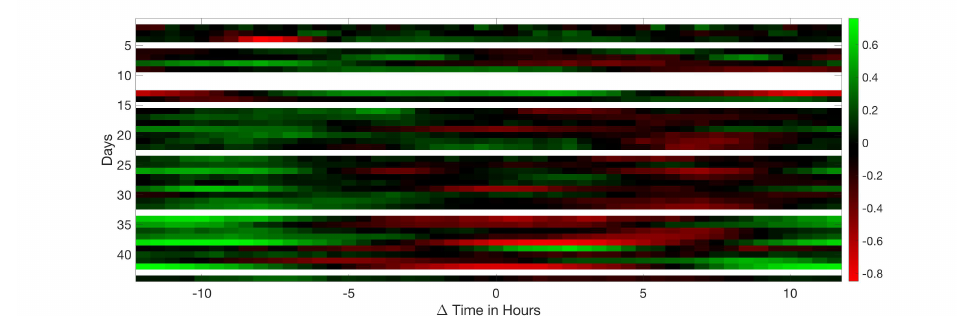
Figure 17. Results of the circular correlation CO 2 — L eq . Horizontal axis corresponds to the ∆ Time measured in hours, evaluating the delay between CO 2 and L eq . Vertical axis stands for the days of the